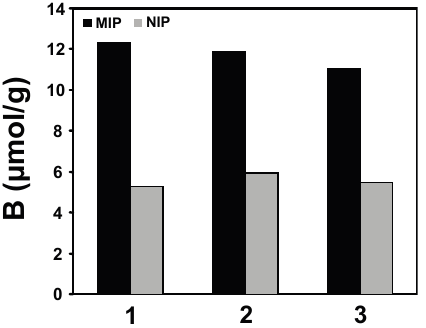
Figure 2. Single analyte binding of ( E )-resveratrol 1 , or the selectophores, the imine 2 , and the amide 3 , to the MIP RES . The standard error of the mean (SEMs) for these binding capacity results was less that ±5% ( n =